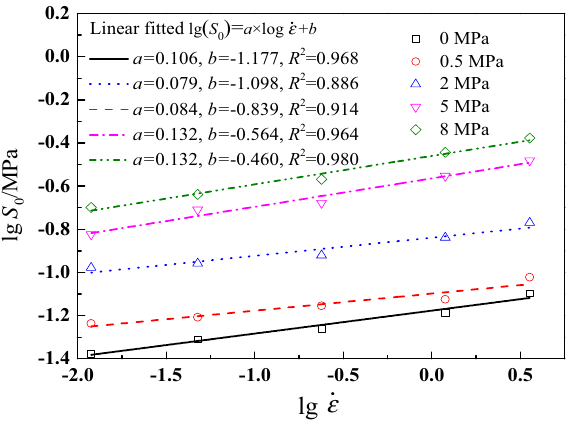
Figure 10. Damage initiation parameter S 0 under different strain rates and confining